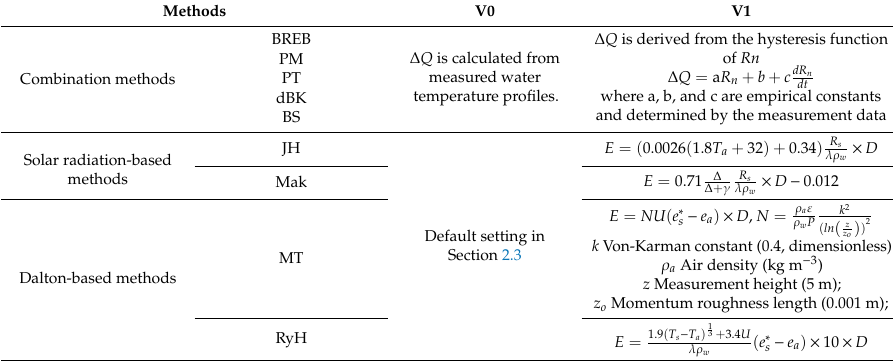
Table 1. Comparisons between the default condition V0 and calibrated condition V1 for the evaporation